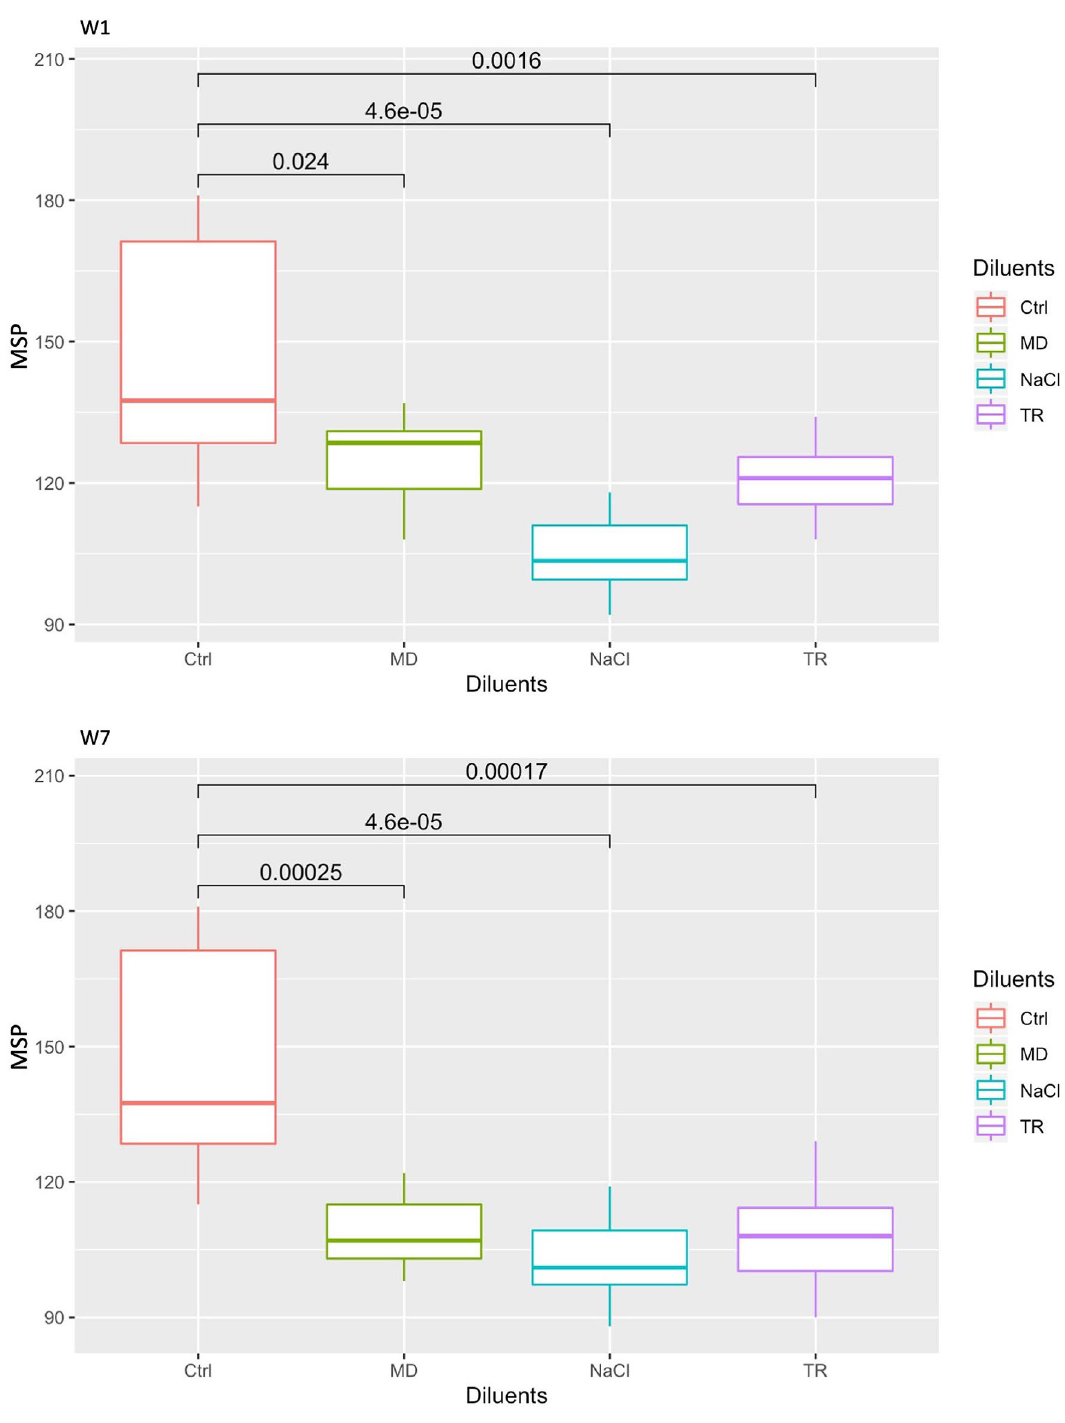
Figure 2. MSP richness in mice transplanted with either a fresh human stool specimen in NaCl (group Ctrl), or the same stool specimen that has been stored at − 80 °C for one week (top panel) or seven weeks (lower panel) in either NaCl, or MD, or TR. Analyses were performed on feces collected on day 2, 4 and